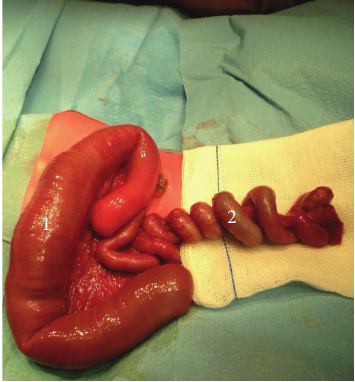
Figure 5: 1, proximal dilated ileum loop ending in a blind pouch. 2, atresic “apple peel” distal portion with approximately 45